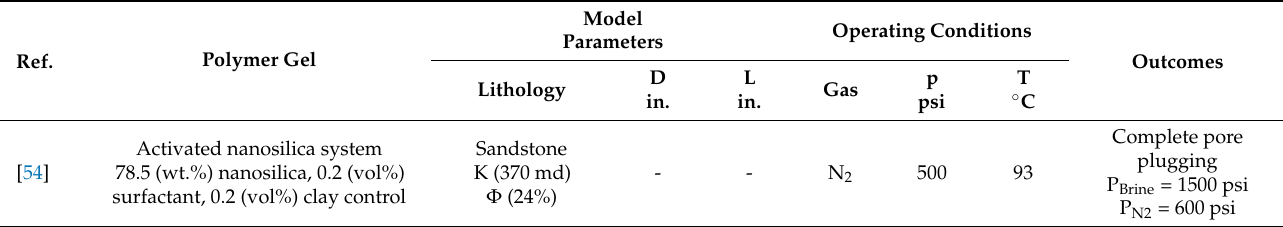
Table 8. Inorganic gel systems—lab evaluation.